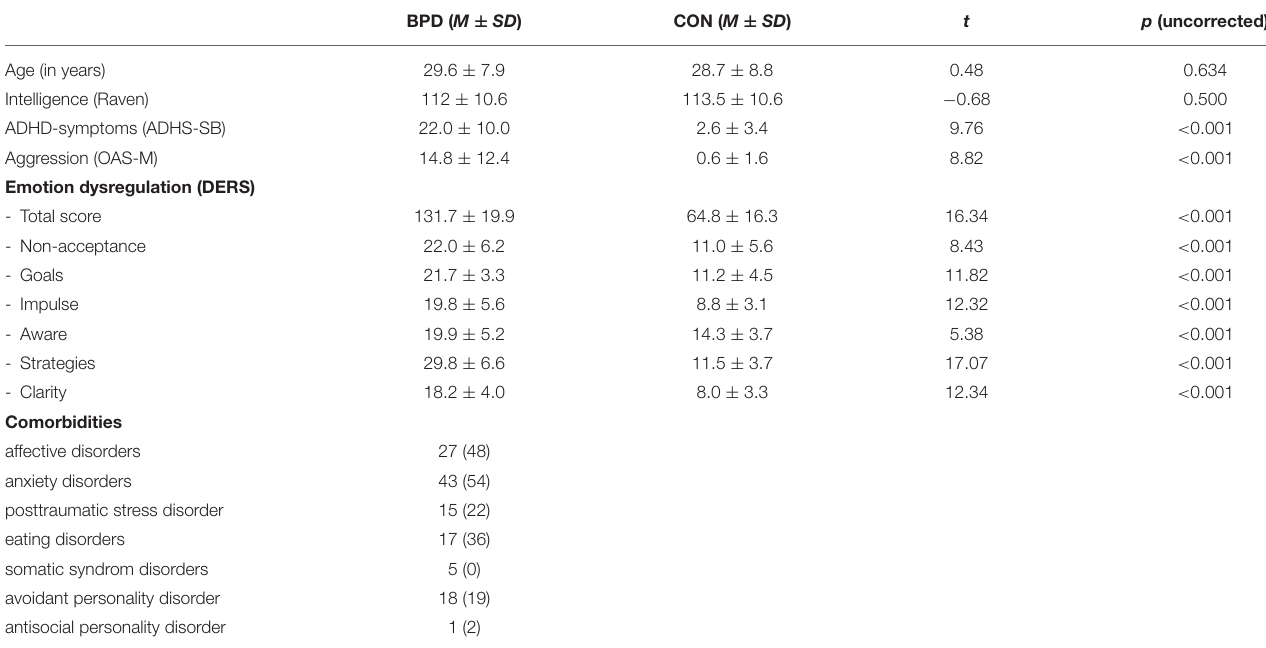
TABLE 1 | Sociodemographic and self-report data of women with borderline personality disorder (BPD; N = 60) and healthy controls (CON; N =